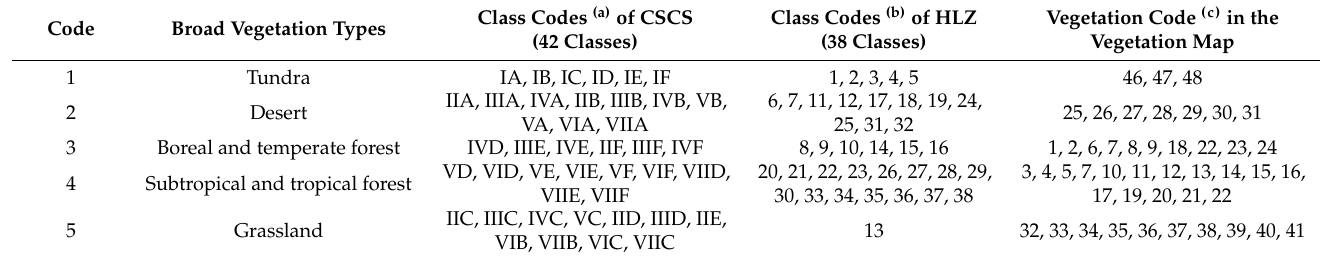
Table 2. Aggregation schemes of climatic classes for CSCS, HLZ, and Vegetation map. Class codes refer to Table A1 in the Appendix A.